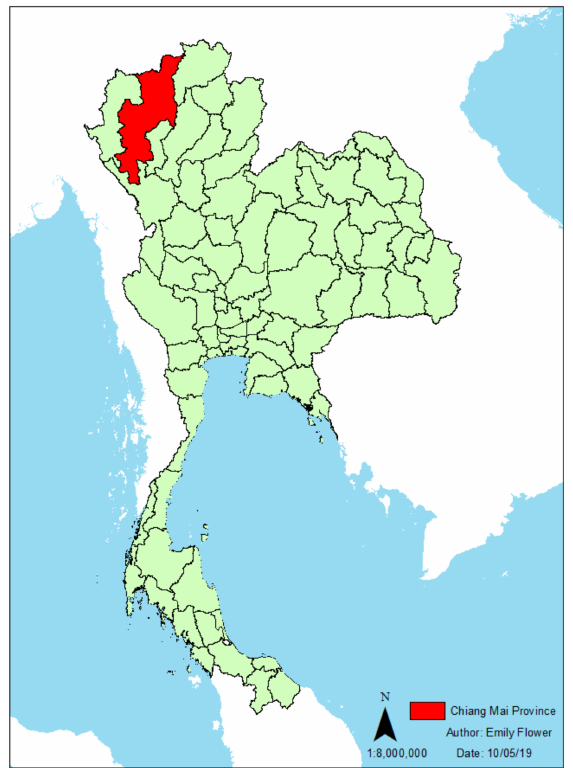
Figure 1. Location of Chiang Mai Province (red area) within